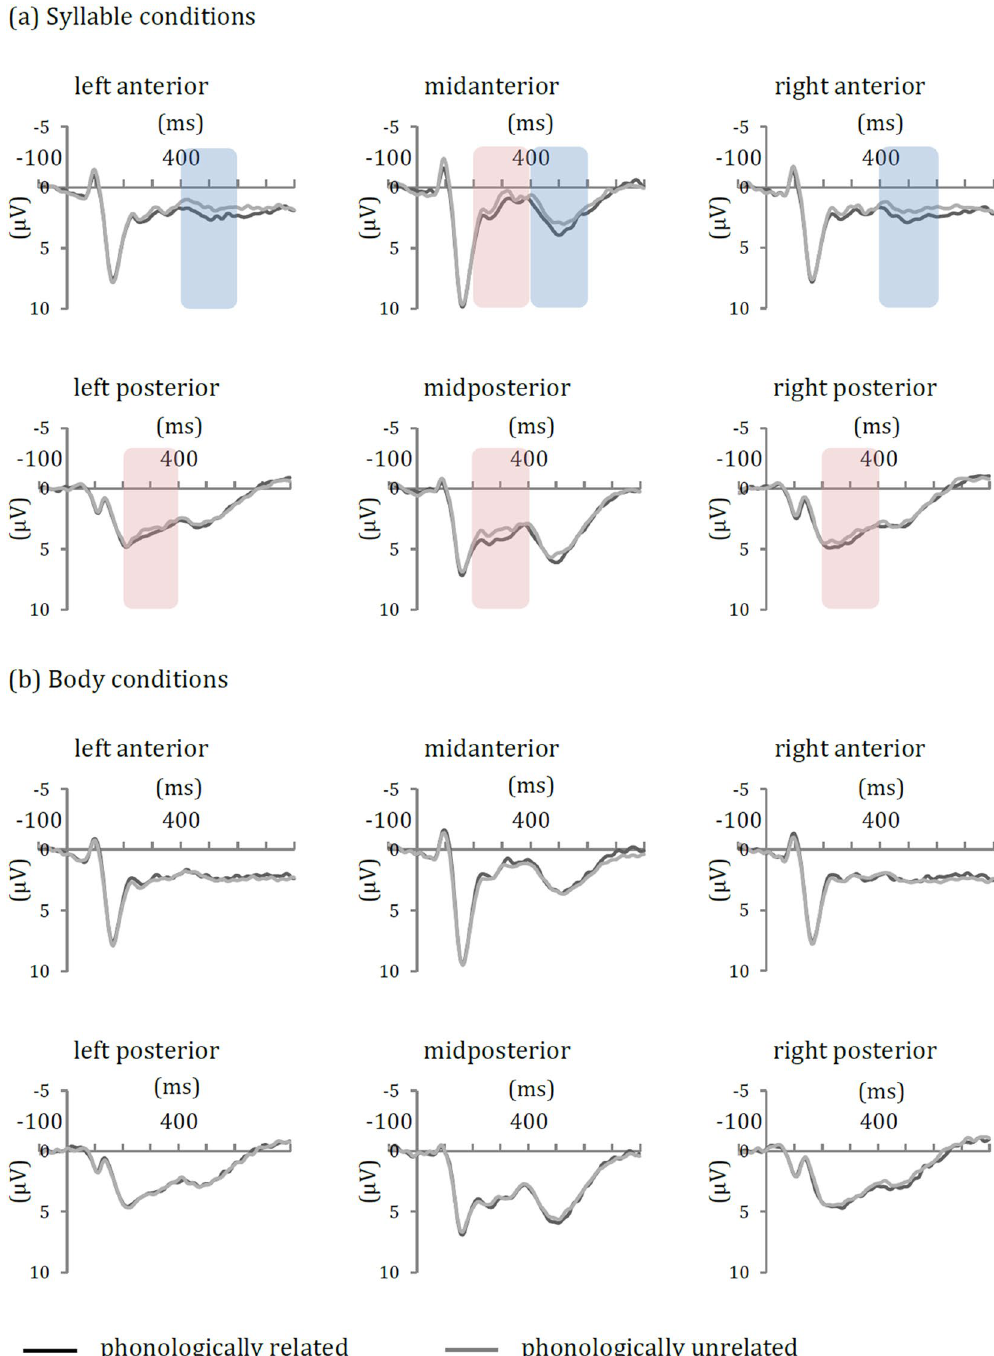
Figure 1. Grand average ERPs in ( a ) the syllable conditions and ( b ) the body conditions at six ROIs: left anterior (F5, F7, FC5), midanterior (Fz, FCz, Cz), right anterior (F6, F8, FC6), left posterior (P5, P7, CP5), midposterior (CPz, Pz, POz) and right posterior (P6, P8, CP6) regions. Only syllable-relatedness induced significant ERP effects after target onset: a widely distributed positivity in the 200- to 400-ms interval (red shading) and an anterior positivity in the 400- to 600-ms interval (blue